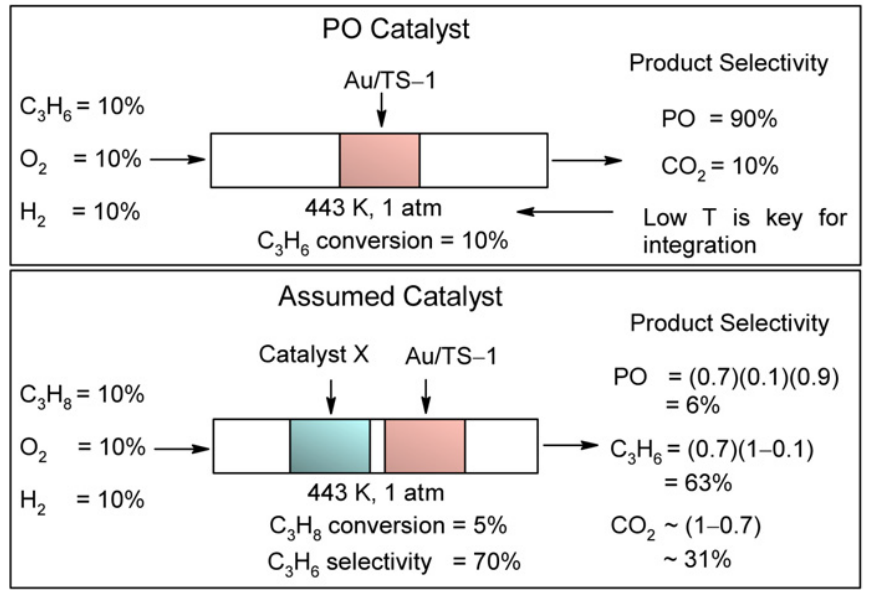
Figure 2. Hypothetical propane to propylene oxide (PO) oxidation process. Reproduced with permission from Reference [15]. Copyright (2008)